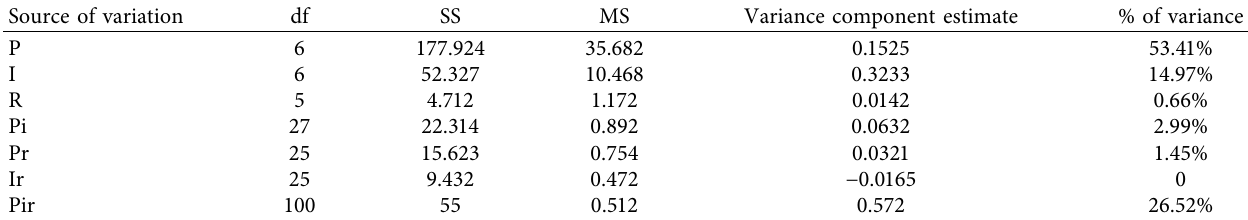
Table 3: p × i × r G-study variance component estimation for design evaluation.